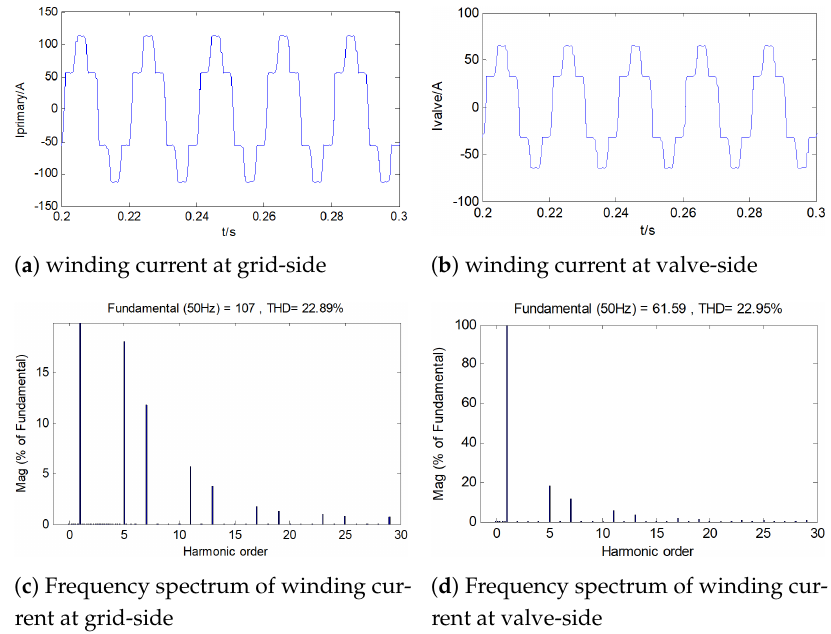
Figure 9. Waveform and frequency spectrum of the winding current from the valve-side and grid-side on the right column of the converter transformer under working condition